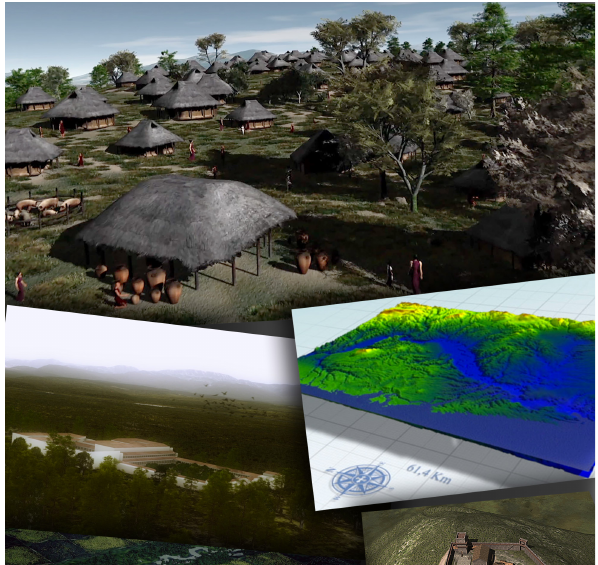
Figure 7. Virtual Museum of the Tiber Valley . 3D reconstruction of the potential landscape in its geological evolution, in the Orientalising and Roman periods.